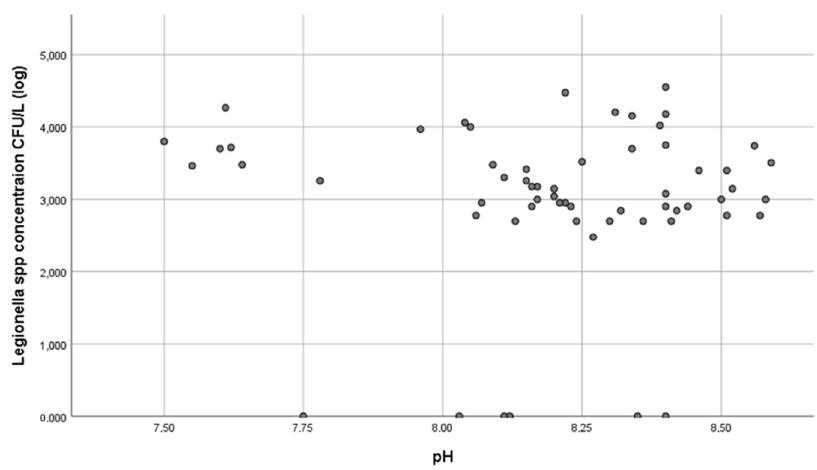
Figure A3. Legionella spp. concentration (on a lgarithmic scale) correlated with pH.